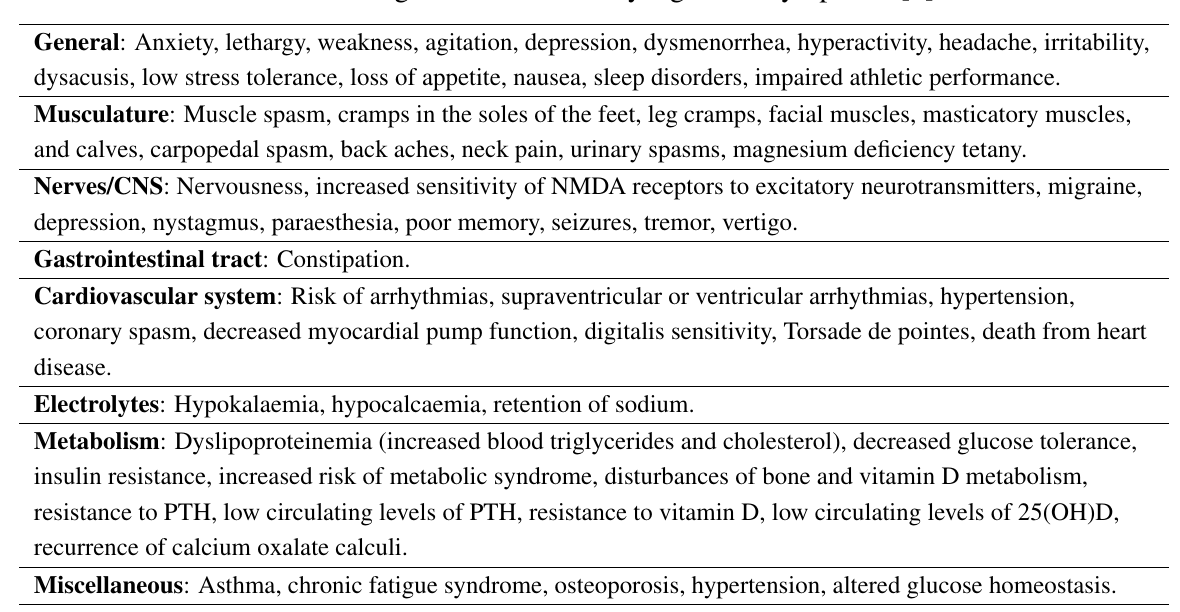
Table 3. Drug-induced magnesium loss and hypomagnesemia [63–65]. Drug Group (Drug